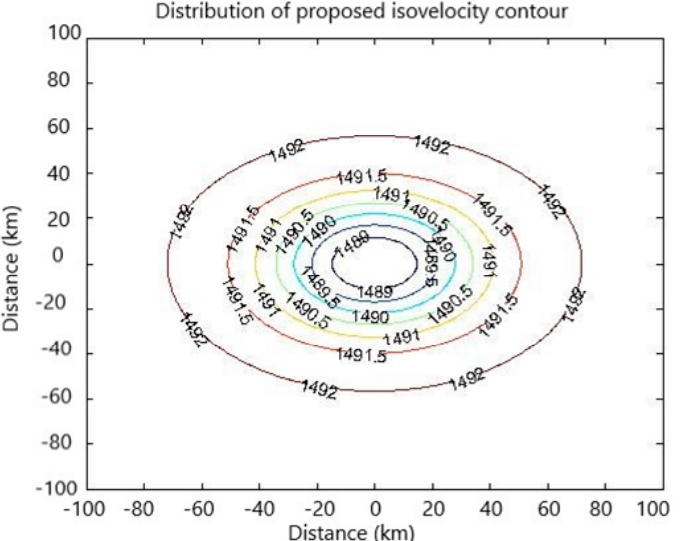
Figure 6. Sound velocity (m/s) distribution image obtained by Gaussian fitting method.